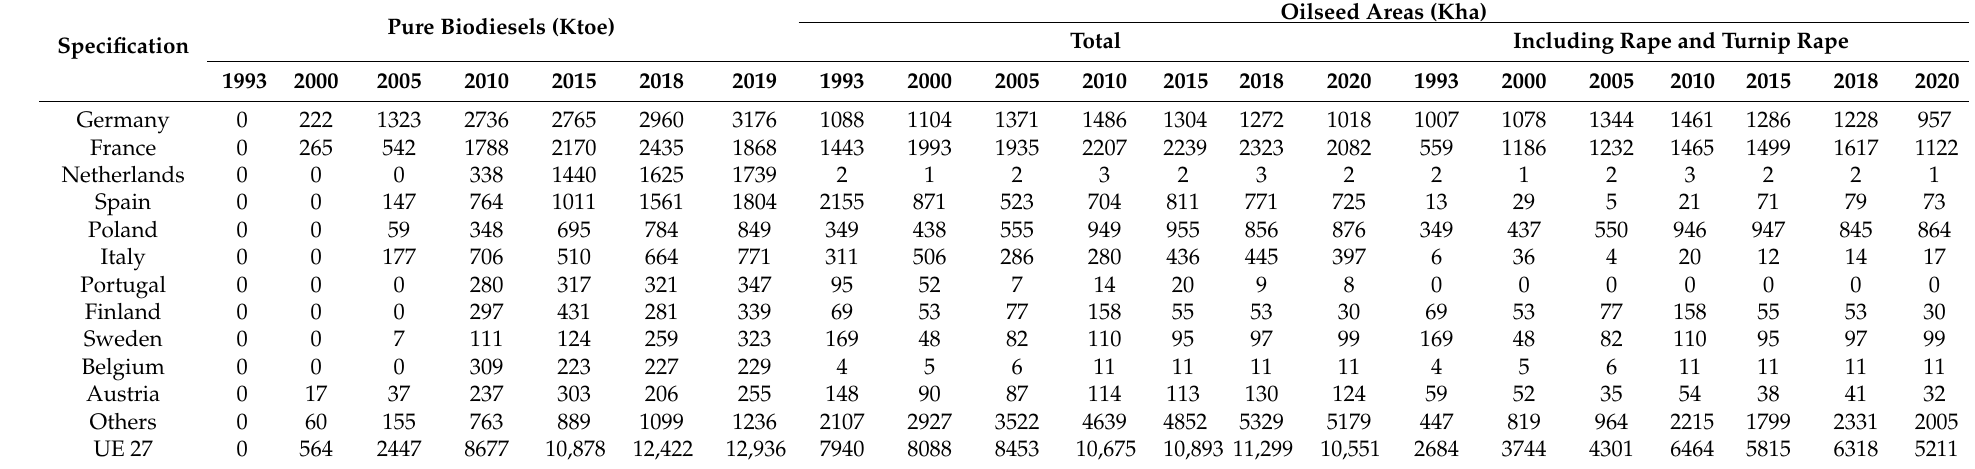
Table 1. Biodiesel production and oilseed areas in selected EU